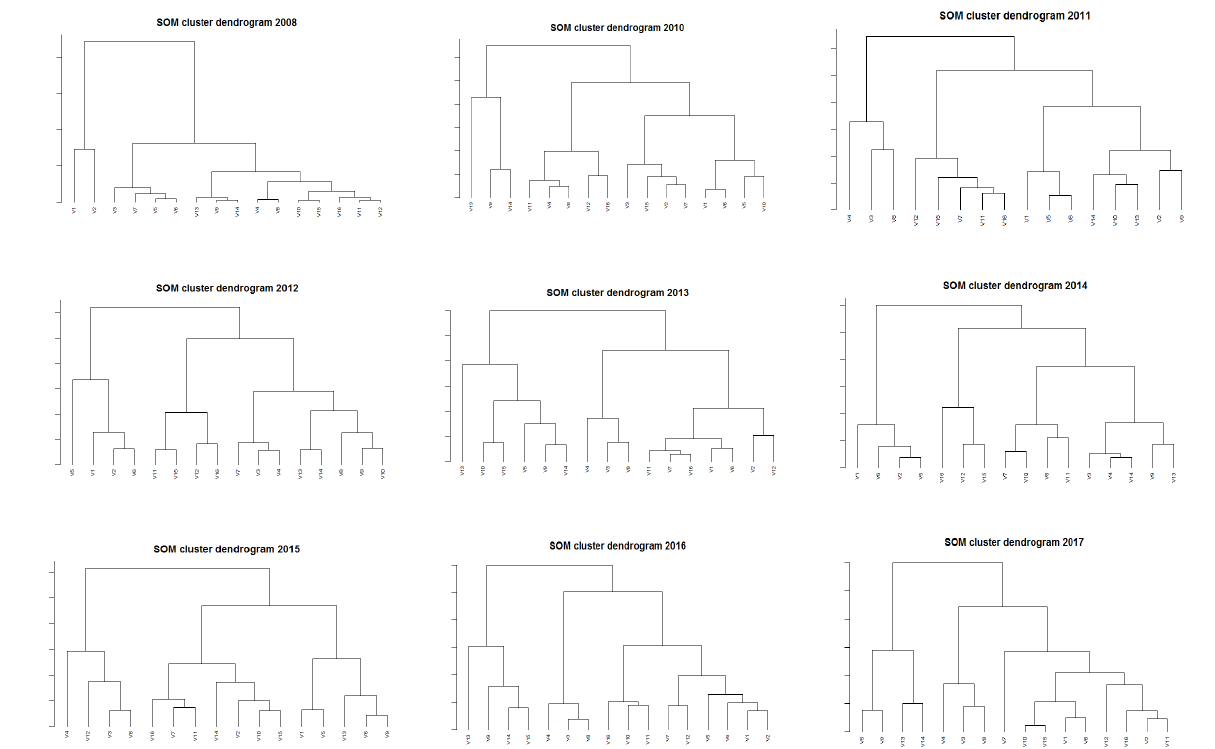
Figure A2. Within group sum of square value. Note: these figures show the within sum of square value in response to the number of clusters (2008–2017). Source: author’s analysis.